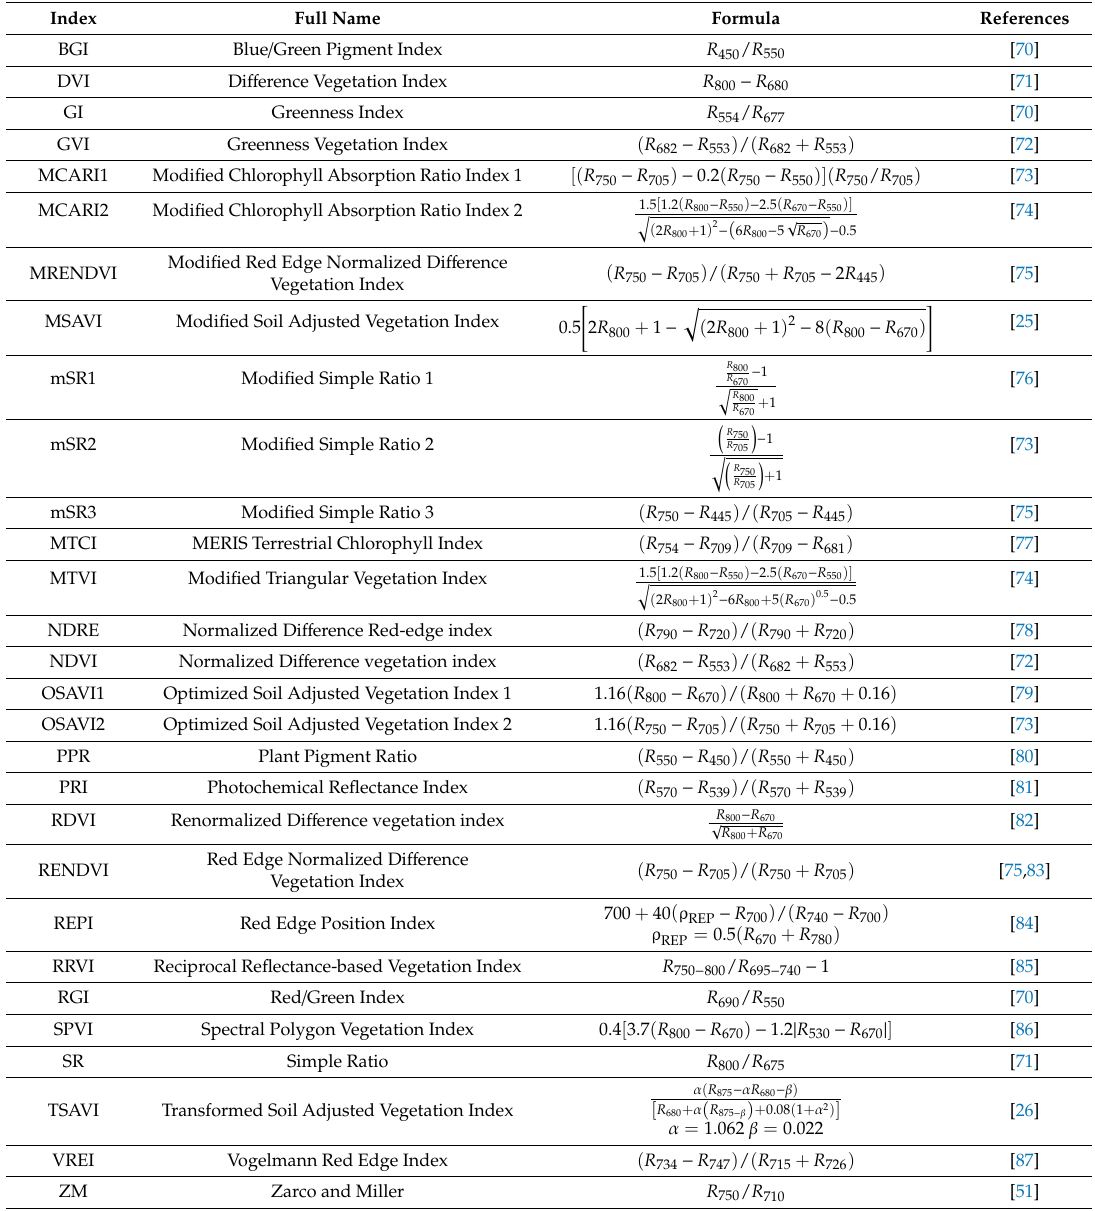
Table 1. Narrowband vegetation indices selected in this research. (R in the formula indicates reflectance, values indicate wavelength in